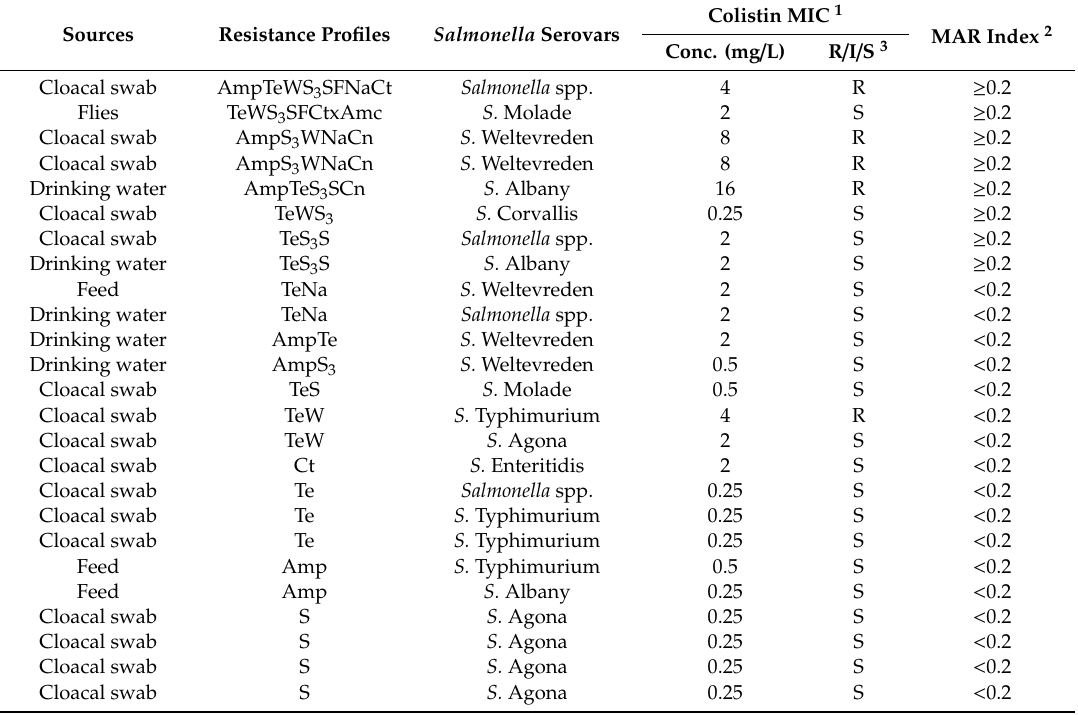
Table 2. Antibiotic resistance patterns of Salmonella recovered from village chickens in the South-central Peninsular